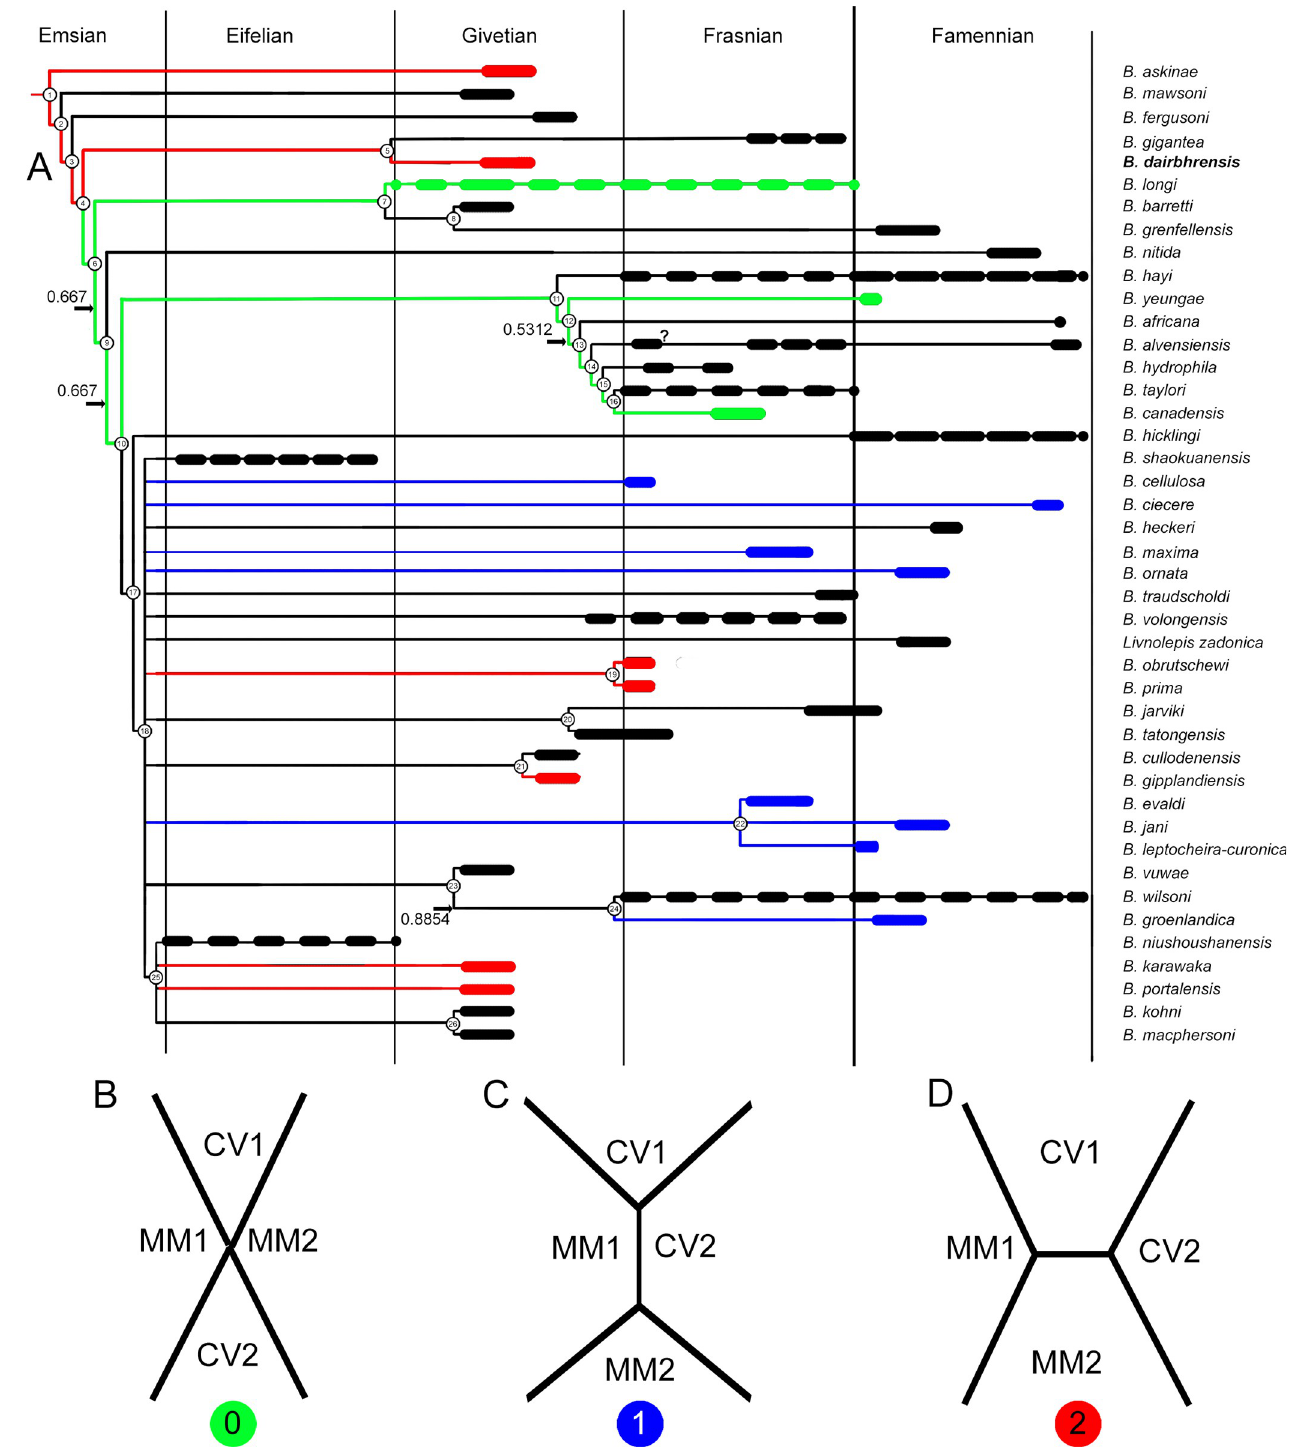
Fig 14. Phylogenetic analysis of the best known species of the genus Bothriolepis [8], with special emphasis on the contact between plates of the proximal segment of the pectoral fin. A. Stratigraphy correlated majority rule (50%) consensus tree (n = 96; L 50% = 251; CI 50% = 0.279; RI 50% = 0.365; indices for polytomies in the strict consensus tree are given on the branches; uncertain ranges indicated with longer dashes). B. CV1, CV2, MM1 and MM2 connect in one point (state 0, green). C. MM1 and CV2 connect and forbid CV1 and MM2 to contact (state 1, blue). D. CV1 and MM2 connect and forbid MM1 and CV2 to contact (state 2,